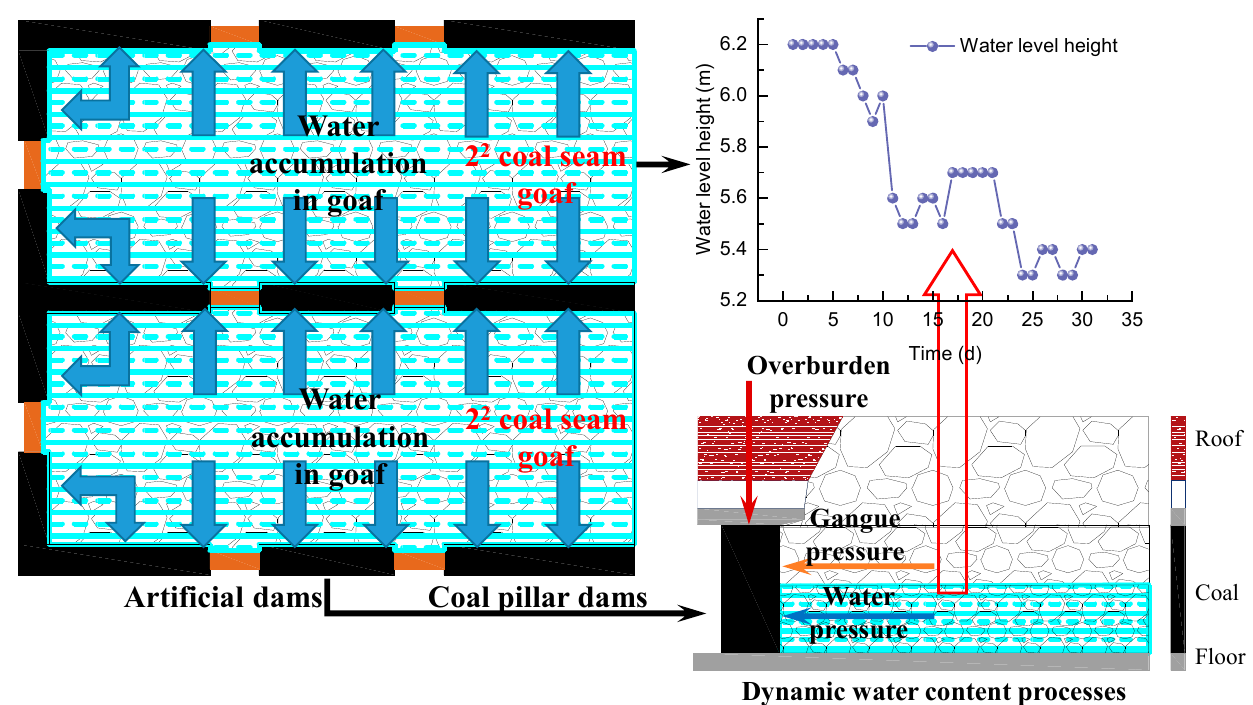
Figure 2. Schematic diagram of water storage in underground reservoir of Shangwan Coal Mine. The 2 2 coal layer is the coal layer of the underground reservoir that is being operated by the Shangwan Coal Mine (2 2 represents No. 2 coal seam of Shangwan Coal Mine). In order to ensure that the experimental conditions are identical to the practical operating environments, we chose the 2 2 coal seam for the subject of this study, which is presented in Figure 3. The natural mean water content is determined to be 7.59%. Based on the requirements from the International Society of Rock Mechanics Test Code [29], the raw coal was machined to 30 standard cylindrical samples of 50 mm × 100 mm with excellent completeness without surface fractures. Because it is inconvenient to measure the moisture content in coal column dam in goaf, four groups of different water content (reflecting the dynamic change of standing water content of coal column dam) and three groups of dry– wet circulating coal samples (reflecting repeated flushing action of water) are designed and numbered according to the form of “grouping-water content/number of cycles-number of blocks”. As an illustration, A-1-1 indicates the first coal sample in the water content group with 0% water content, and B-1-2 indicates dry–wet cycle. Information on the grouping of coal samples is shown in Table 1. Table 1. Specimen numbering